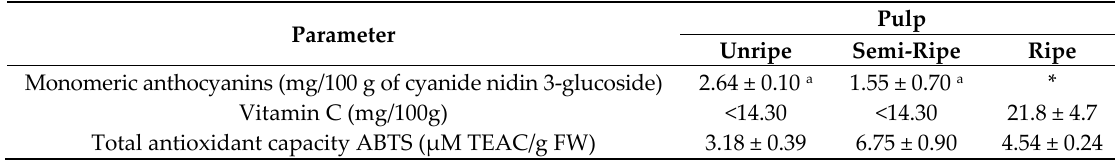
Table 3. Anthocyanins, vitamin C content and total antioxidant capacity (ABTS) in three stages of maturity in Sicana odorifera fruit